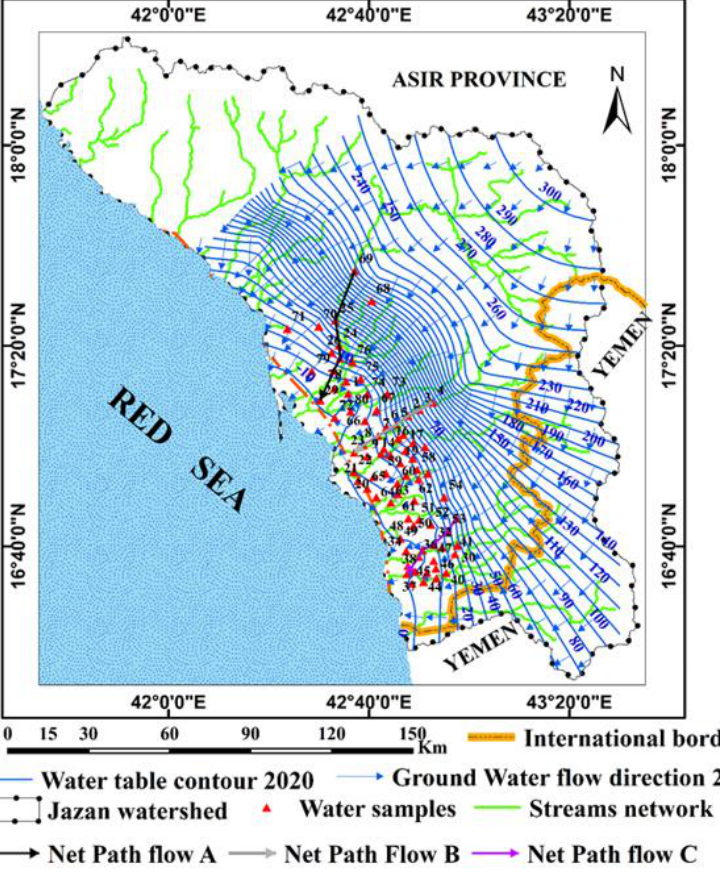
Figure 6. Directions of the evolution for selected flowpaths according to the groundwater flow direction of the water table (interpolation by Kriging method). Table 2. The mineralogical evolution along the selected